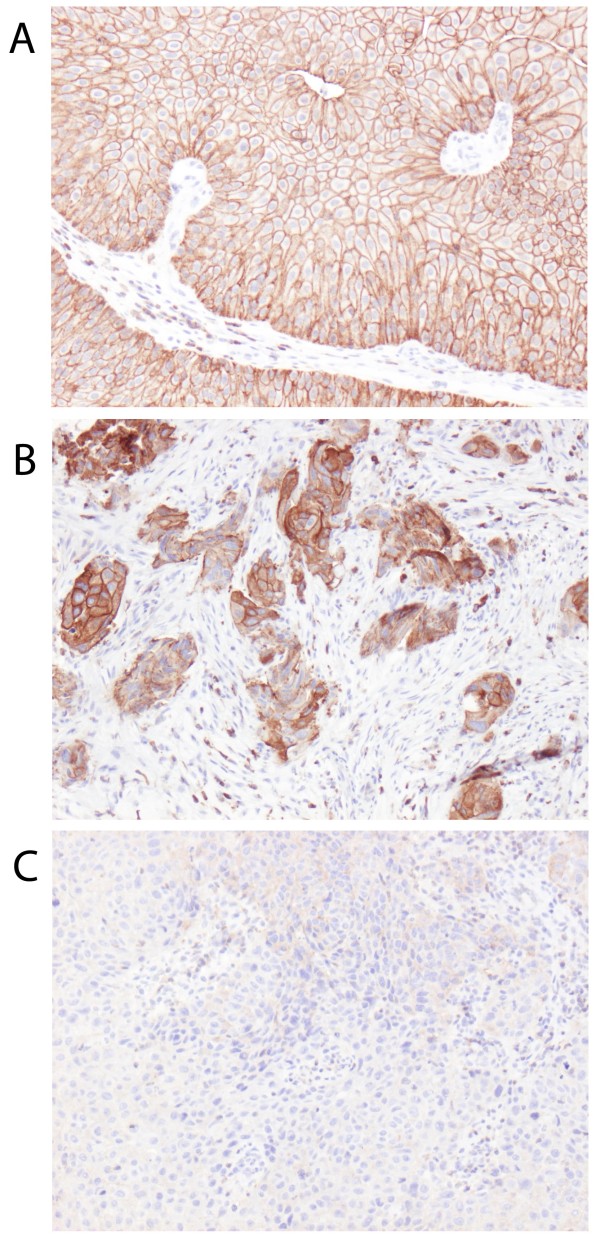
Sample immunohistochemical images of ezrin expression. Images (20x magnification) representing tumours with (A) nearly 100%, (B) approximately 50% and (C) negative ezrin expression.